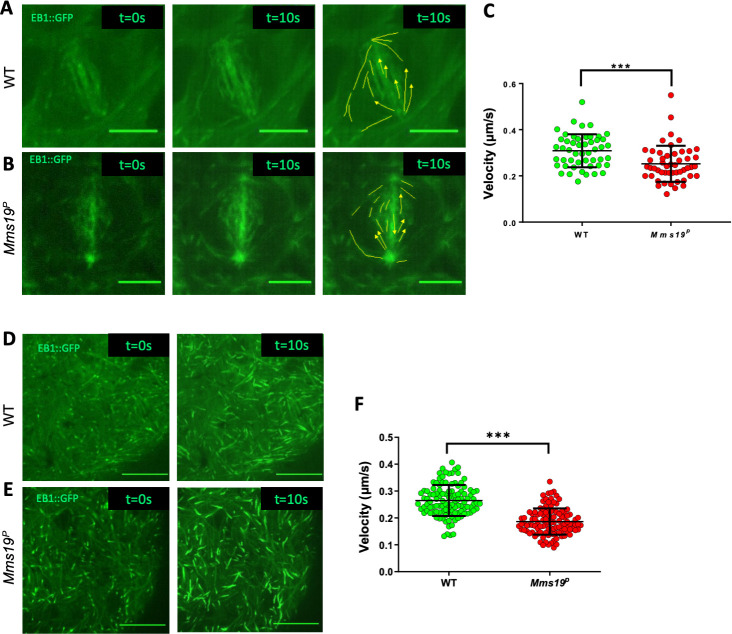
Mms19 assists MT polymerization in vivo.(A-B) WT and Mms19P NBs expressing EB1::GFP were imaged live, and time-lapse movies were acquired to calculate the velocity of EB1::GFP labelled MT ‘plus’ ends. The left panel shows the image of a single time frame. The central panel shows a projection of 20 time points (taken over 10s). In the far right panel, individual EB1::GFP comets are tracked. The velocities represented in (C) show reduced MT growth velocity in Mms19P NB spindles. n = 11 cells per genotype, 4–5 tips analyzed from each cell, 1 experiment. (D-E) EB1::GFP expressing surface glia cells were imaged live to analyze the MT plus end velocities. The left panel shows a single time frame and the right-side panel shows a projection of 20 time points (taken over 10s). The velocities represented in (F) show reduced MT growth velocity in Mms19P glia. n = 15 brains from each genotype, 7–8 tips analyzed from each brain, 1 experiment. SS for C and F was calculated using unpaired t-test, (***P<0.001), scale bar = 5μm.